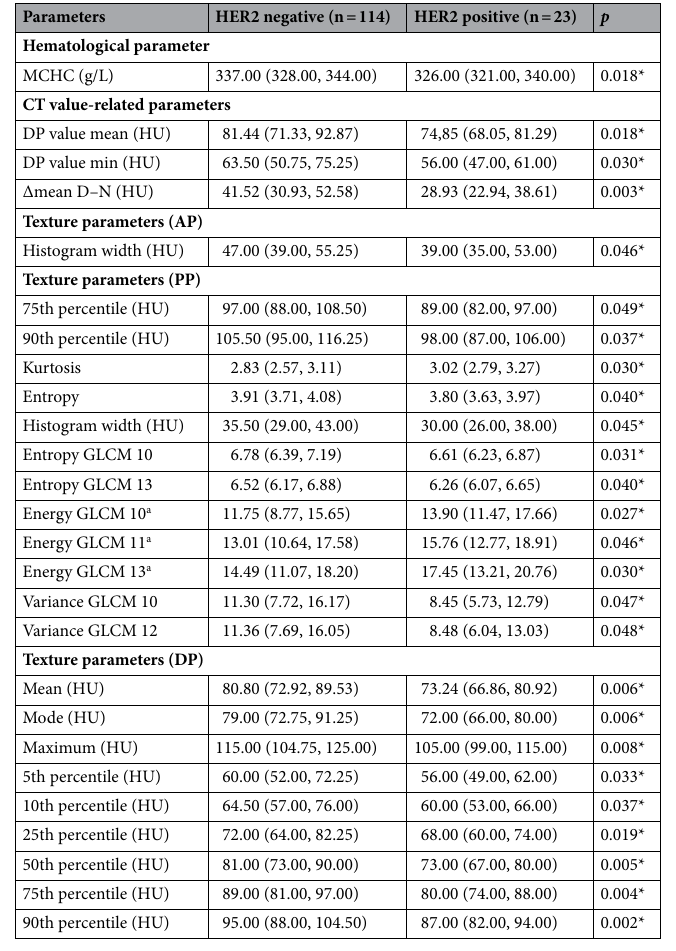
Table 3. Statistical description and univariate analysis in the primary cohort. The data are presented as median with (1st quartile, 3rd quartile); HER2 human epidermal growth factor receptor 2, MCHC mean corpuscular hemoglobin concentration, CT computed tomography, AP arterial phase, PP portal phase, DP delayed phase, GLCM gray-level cooccurrence matrix; a × 10 –3 ; * p < 0.05 with Mann–Whitney U test.